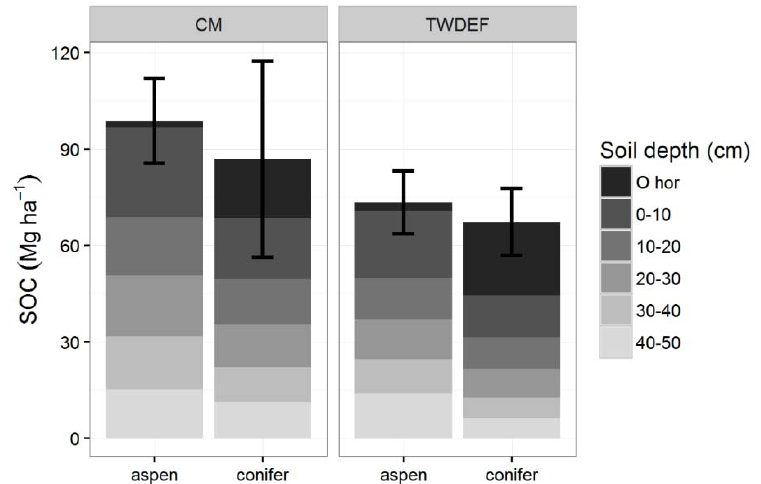
Figure 2. Soil organic carbon (SOC) stocks (Mg C · ha − 1 ) for aspen and conifer at CM and TWDEF. Values are averages of four paired sites at CM, and three plot pairs at TWDEF. Error bars are standard deviations for the total SOC stocks (O-horizon − 50 cm) across the sites and plots ( p = 0.51, ES = 0.32 for total SOC stocks, and p = 0.08, ES = 1.03 for mineral SOC stocks).